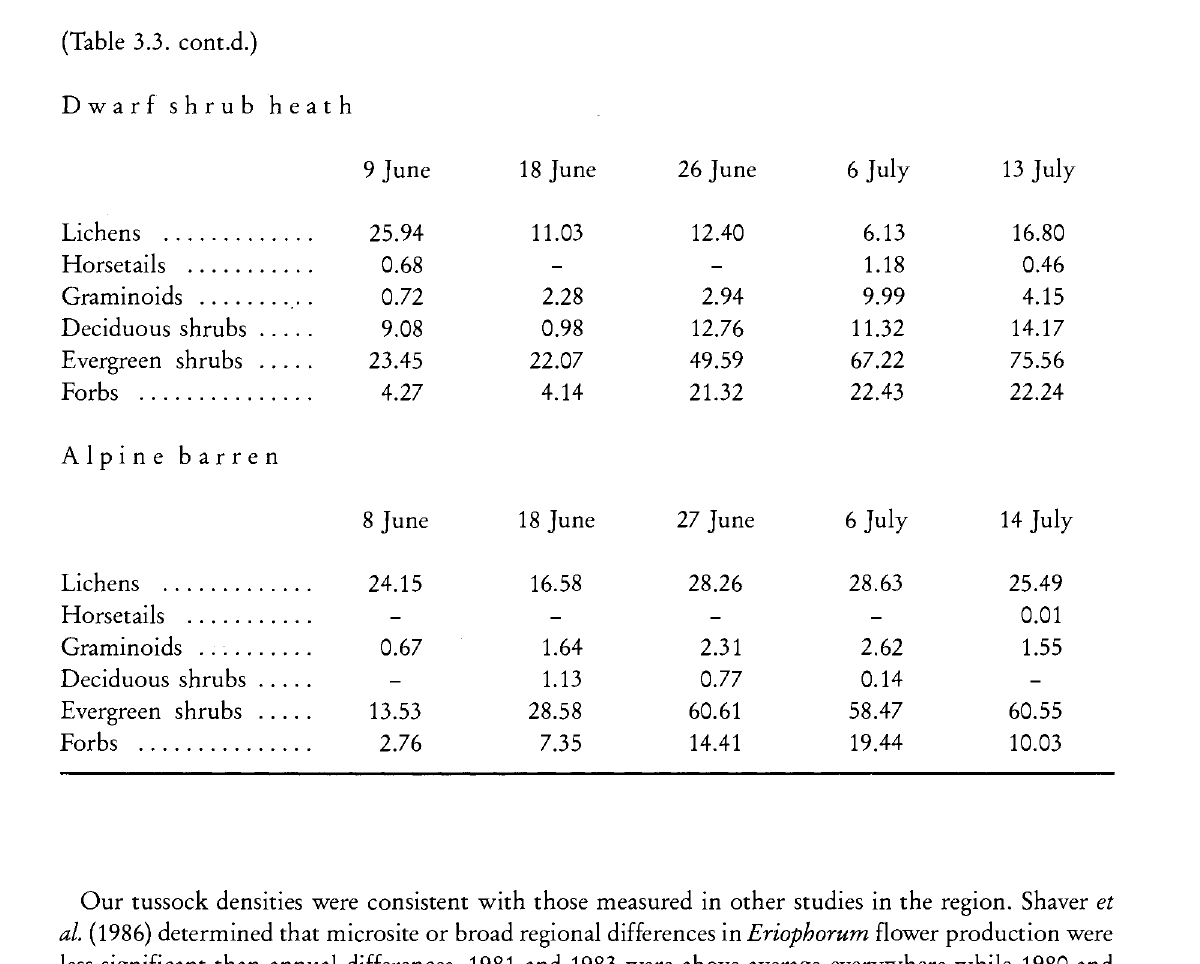
Table 3.4. Summary of tussock variables for the eight stands sampled on the calving grounds of the Porcu pine Caribou